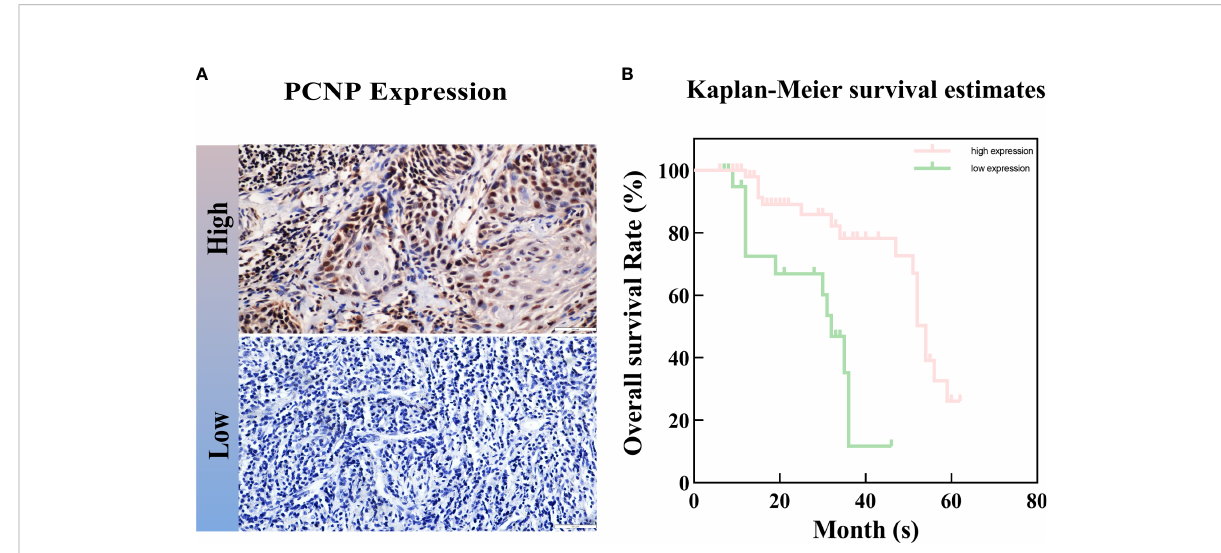
FIGURE 5 Kaplan-Meier survival curves based on PCNP expression (low expression, green line; high expression, pink line). (A) High and low expression of PCNP. (B) Kaplan-Meier survival